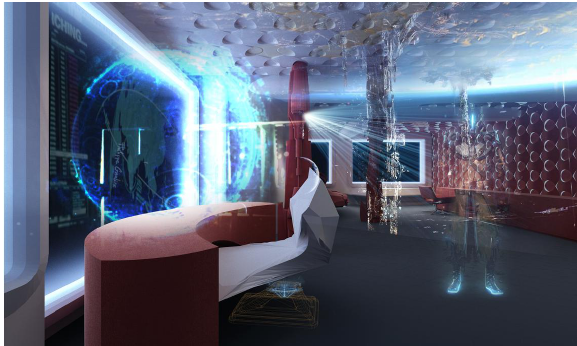
Fig. 3. Image semantic